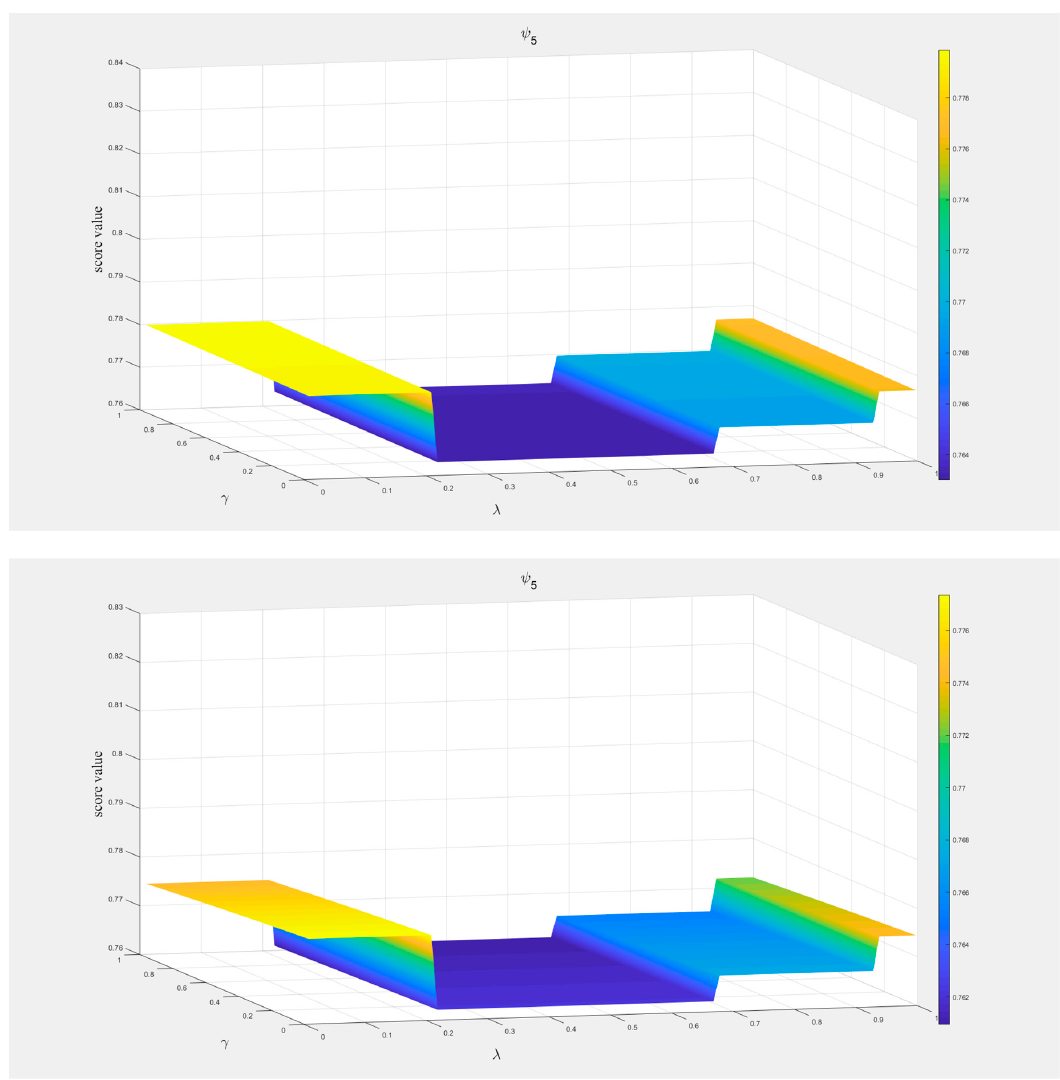
Figure 6. Score values of ψ 5 with γ , λ ∈ ( 0, 10 ] by using two proposed operators.